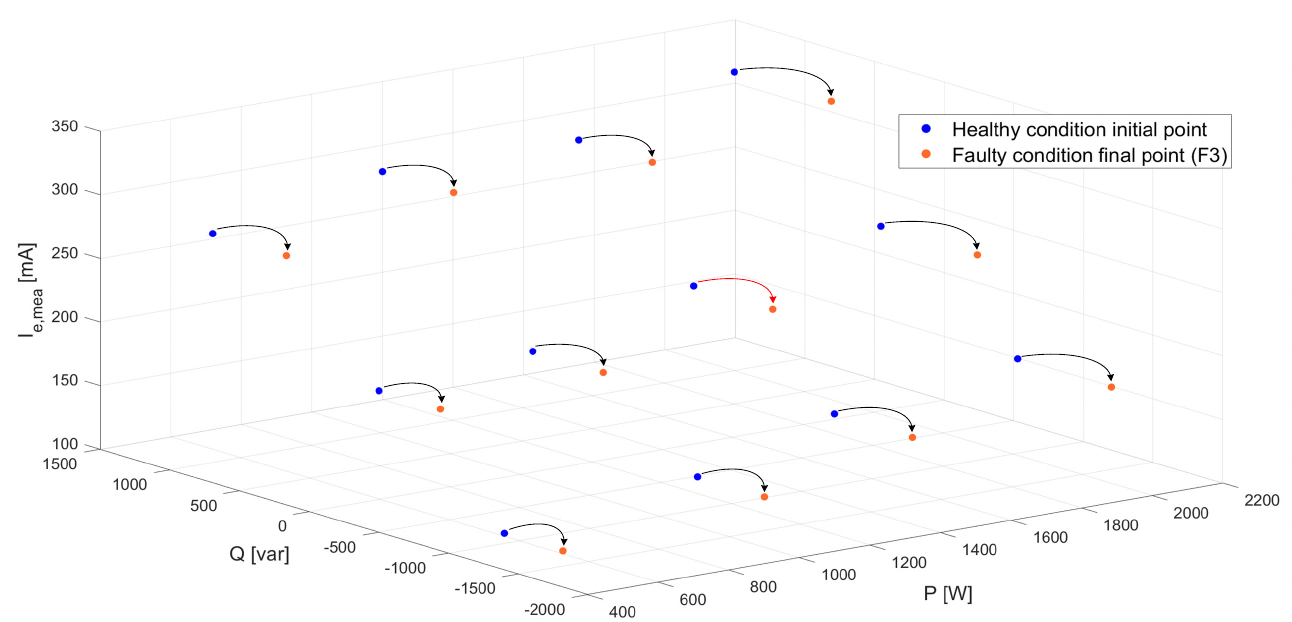
Figure 14. Experimental results. Representation of I e,mea for (P, Q) operating points at U = 400 V both in healthy conditions and in faulty conditions (F3: open-phase fault).